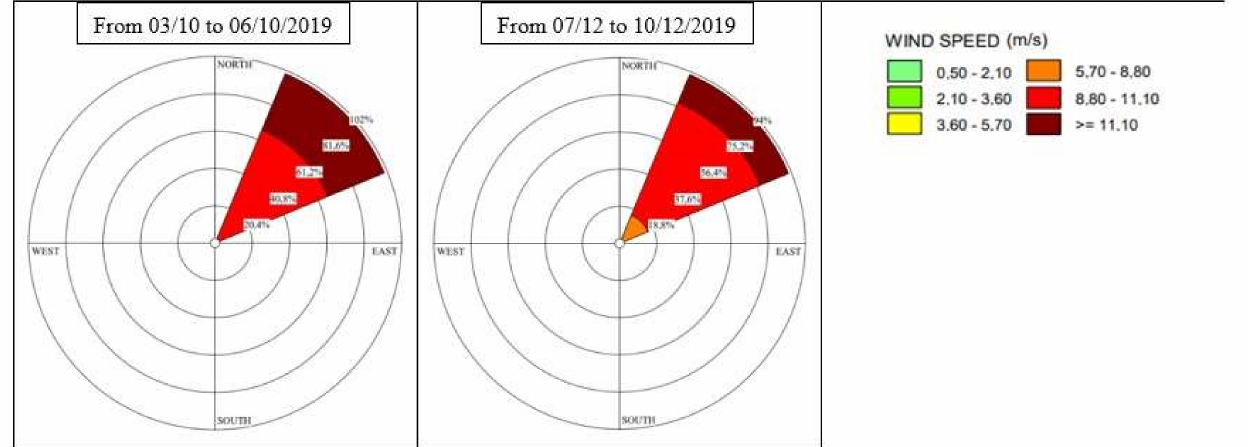
Figure 10. Compass rose containing wind speed (gust) and direction over the months of 2019. It was not possible to generate the graph for the month of November due to lack of data. The data were made available by INMET, on the portal https://portal.inmet.gov.br/ (accessed on 26 February 2020), and extracted from the conventional meteorological station Morada Nova/CE.